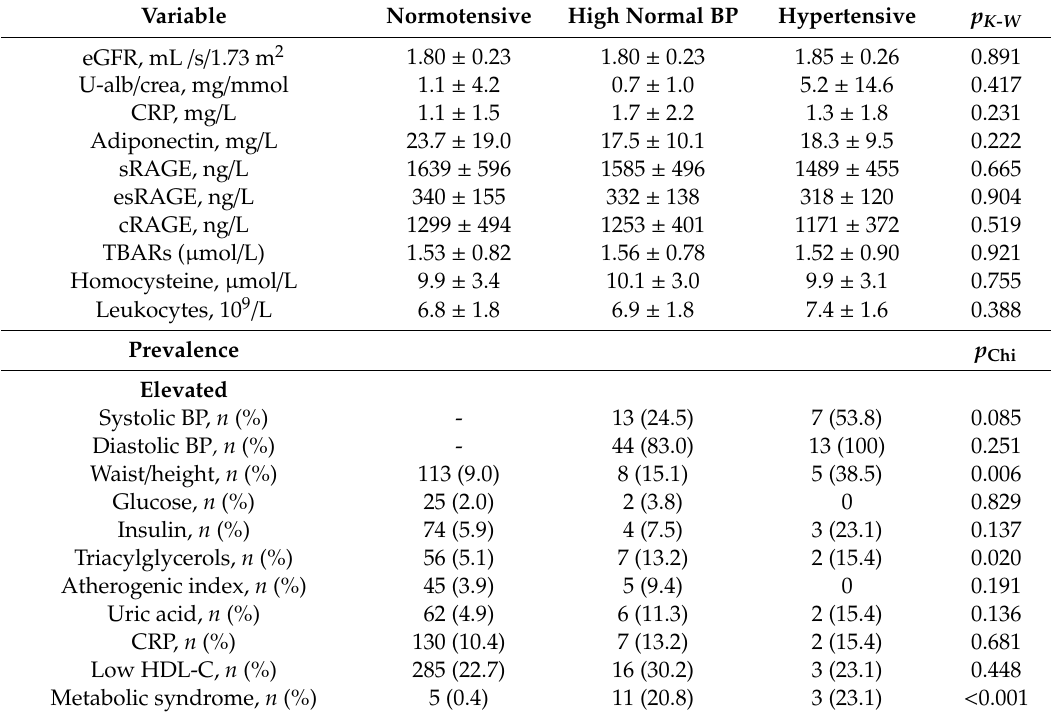
Table 7. Characteristics of